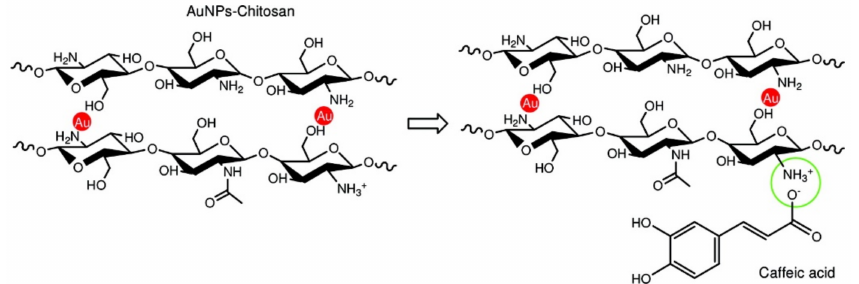
Figure 3. Schematic representation of the interaction between the AuNPs/chitosan nanocomposite and caffeic acid. Reprinted with the permission from reference [60]. Copyright 2012 American Chemical